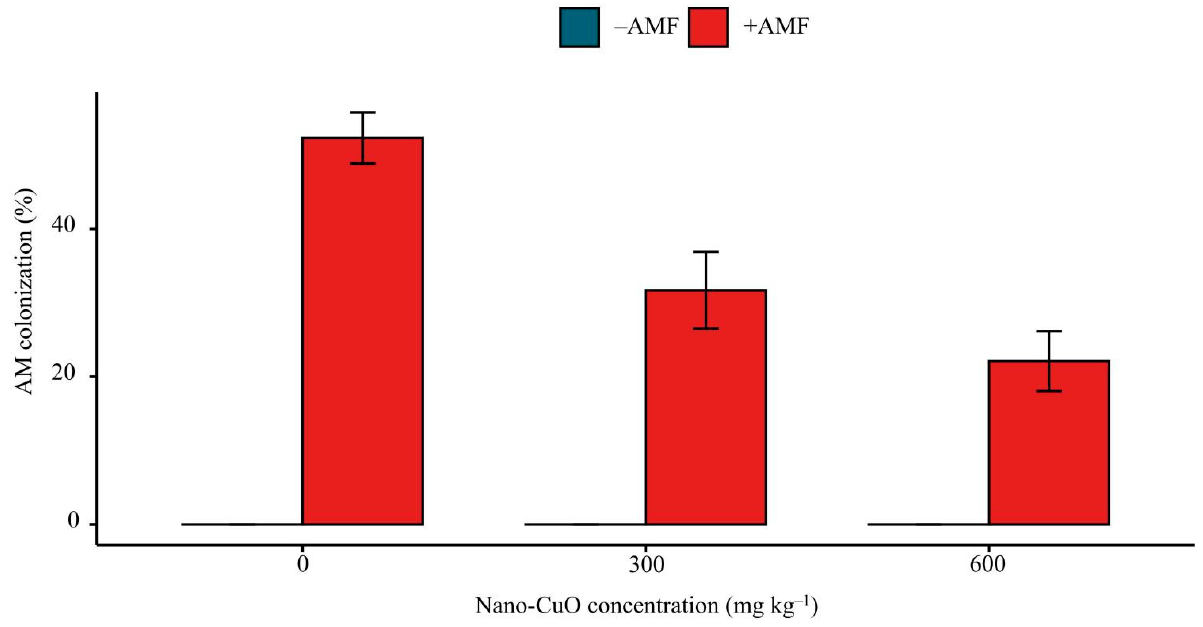
Figure 3. AM colonization of C. indica roots under nano-CuO stress. Increased nano-CuO levels in the substrate increased Cu content while decreasing P concentration in C. indica shoots and roots. Under nano-CuO stress and AM fungal inoculation circumstances, the Cu content in shoots and P content in roots of C. indica plants did not differ from the non-AMF inoculation treated plants. However, the Cu content in the C. indica roots decreased by 20.1% and 11.7% under 300 and 600 mg kg − 1 nano-CuO stresses, respectively (Table 1). The P content in the shoots of C. indica inoculated with AMF was significantly higher than that in the treated plants without AMF under 0, and 300 mg kg − 1 nano-CuO stresses, but AMF inoculation had no influence on the P content in the C. indica roots under the 600 mg kg − 1 nano-CuO